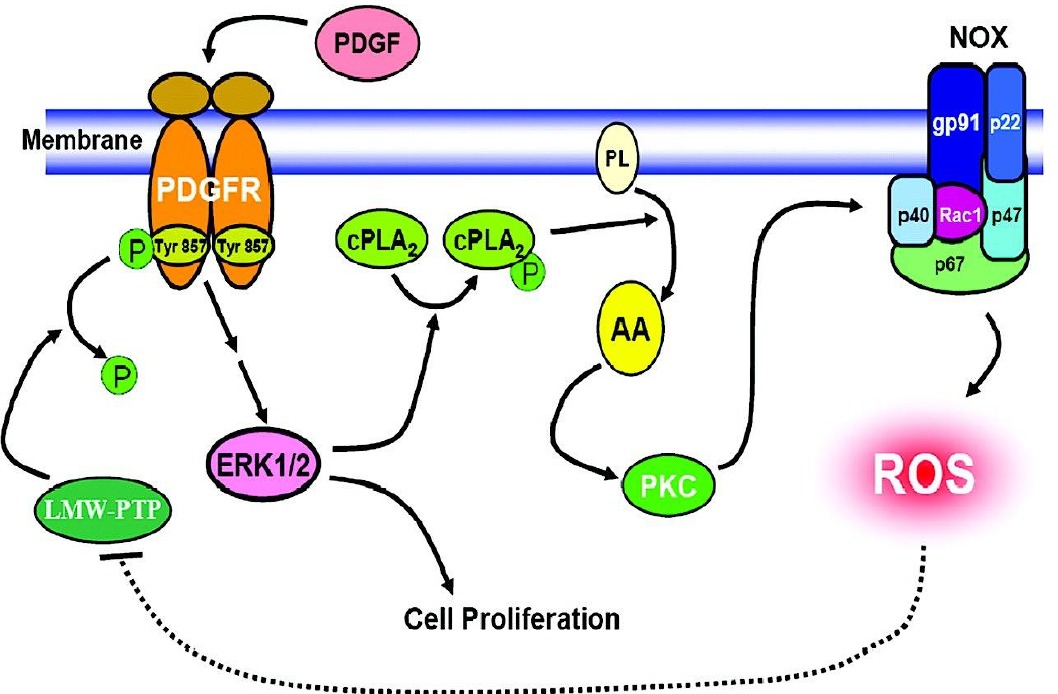
Figure 12. The proposed molecular mechanism of NOX regulation in PDGF-induced mitogenic signaling. Dashed line: proposed pathway; solid line: known pathway. Reprinted with permission from Wang and Lou, IOVS (2009); Copyright ARVO 2009 [92].